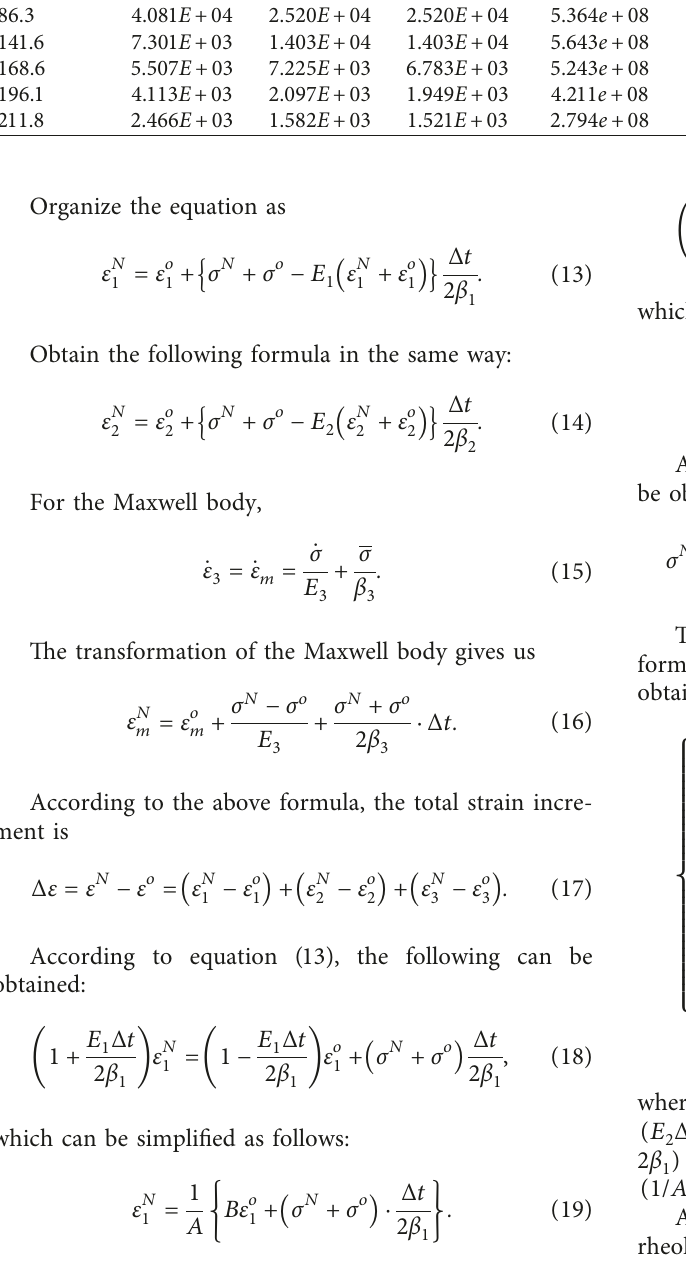
Figure 3: Extended Burgers creep model ( E Table 2: Three-axis rheological experiment fitted according to the improved Burgers model (confining pressure: 300kPa). Deviatoric Shear stress q modulus G 0